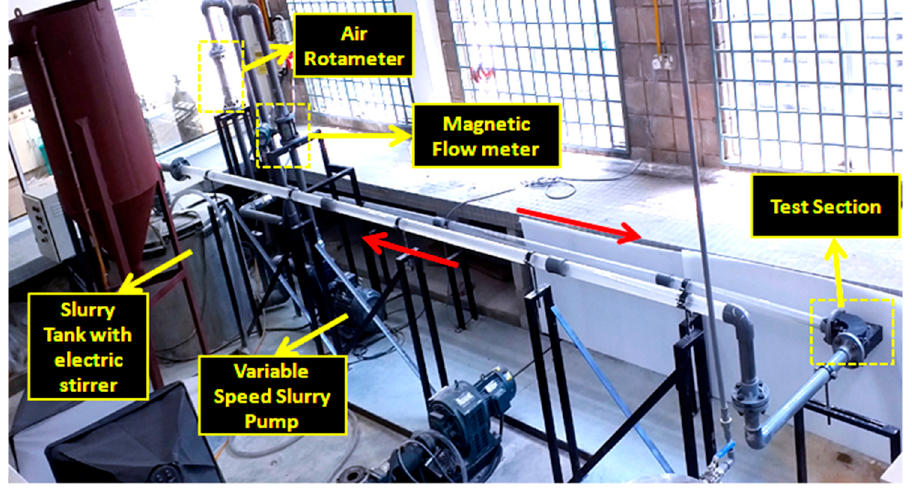
Figure 4. Layout of the experimental setup.